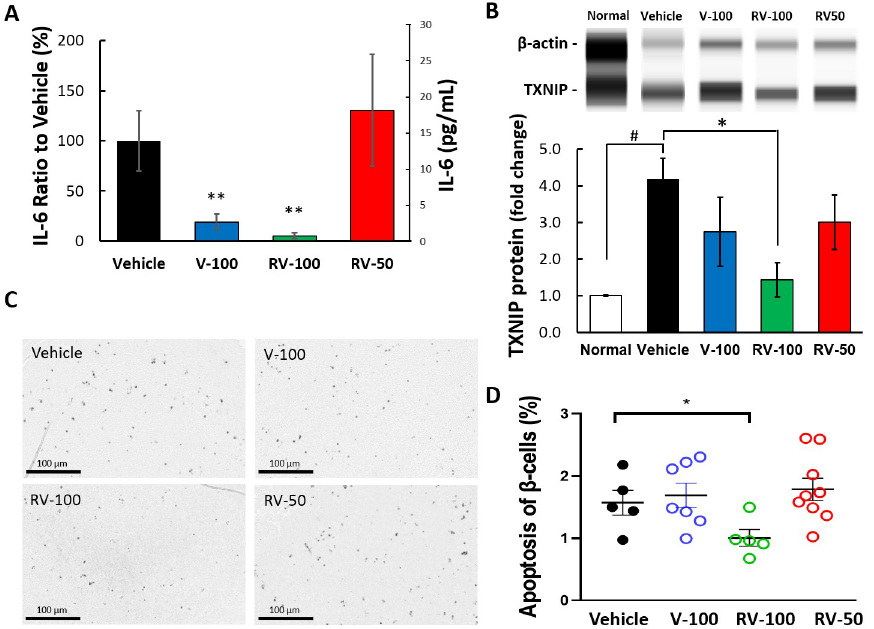
Fig 5. Proinflammatory cytokine (IL-6) and TXNIP expression and TUNEL assay for STZ-induced mice treated with Verapamil (V) and R-Vera (RV). (A) STZ-induced mice administered 100 mg/kg/day racemic or R-Vera exhibited significantly reduced serum IL-6 expression compared to vehicle mice whereas those administered 50 mg/ kg/day R-Vera did not. �� P < 0.01 indicates significant difference from vehicle using one-way ANOVA. N = 8 in each group. (B) STZ-induced mice showed highly upregulated islet tissue TXNIP compared to normal C57BL/6J mice. TXNIP was downregulated after racemic or R-Vera administration compared to vehicle. # P < 0.05 indicated significant difference between normal and vehicle; � P < 0.05 indicated significant difference to vehicle using one-way ANOVA. N = 8 in each group. (C) β -cell apoptosis assessed using TUNEL staining. Deep staining spots in images are apoptotic β -cells (200 × ). (D) TUNEL-positive cell counts show that STZ-induced mice administered 100 mg/kg/day R-Vera had significantly reduce β -cell apoptosis. � P < 0.05 indicated a significant difference between vehicle and RV- 100 using one-way ANOVA. The sample numbers of 5, 7, 5, and 9 indicate the section numbers from the Vehicle, V- 100, RV-100, and RV-50 groups, respectively (rather than the number of mice). Each data point represents the percentage of TUNEL–positive cells per slide in each